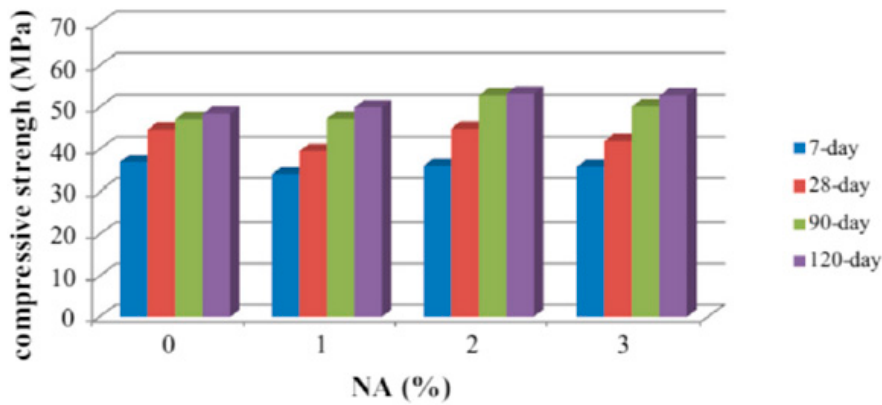
Figure 8. CS of alkali-activated slag without and with nano-Al 2 O 3 inclusion [173].